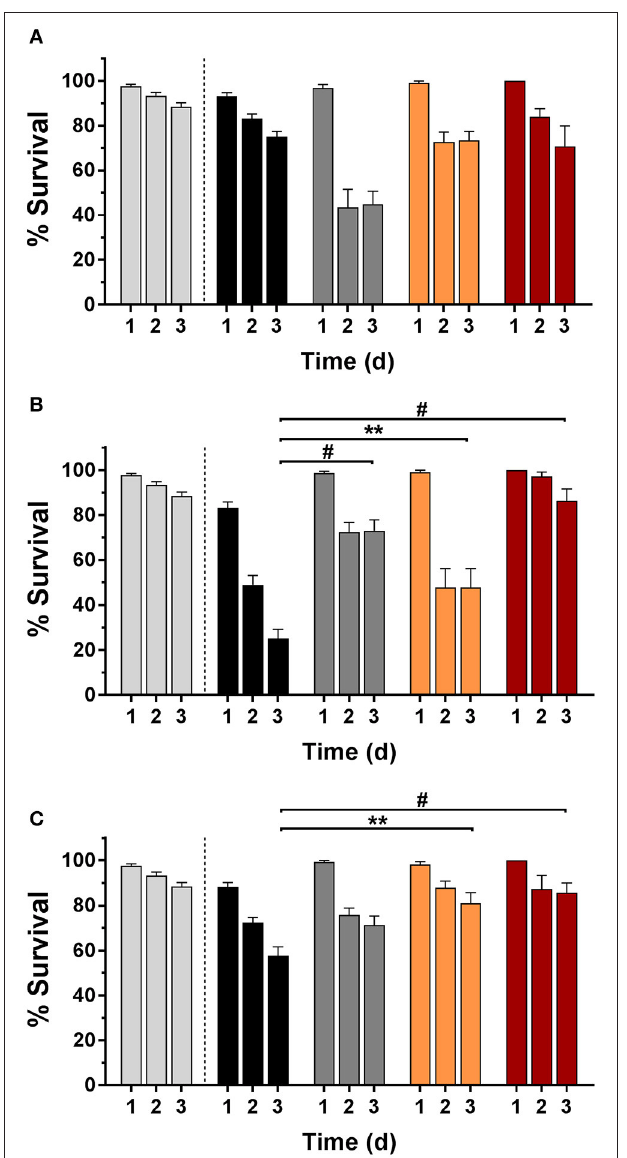
FIGURE 7 | C. elegans survival (%) over 3 days in uninfected controls (light gray) and after infection (black bars) with small colony variant SCV1 (A) , SCV2 (B) or parent strain P1 (C) and treatment with loaded hydrogels: deferiprone 20 mM (Def, dark gray), gallium-protoporphyrin 500 µ g/ml (GaPP, orange), and Def-GaPP500 (red). Data represent the mean ± SEM of at least six biological replicates. ** p < 0.01; # p < 0.0001.